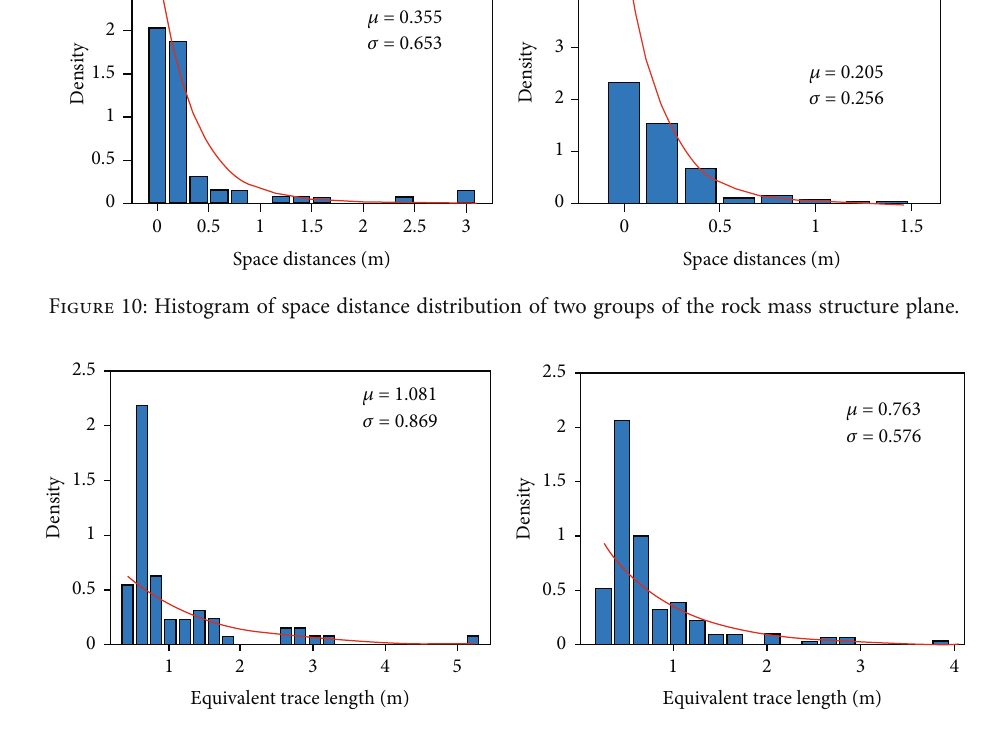
Figure 11: Histogram of equivalent trace length distribution of two groups of rock mass structure plane. Table 2: Mathematical statistical information of rock mass structural